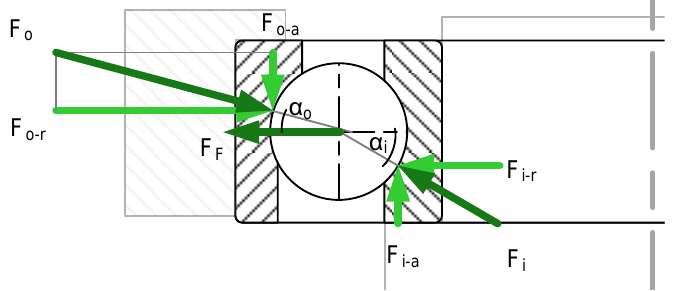
Figure 10. Force situation inside an angular contact spindle bearing including centrifugal force.